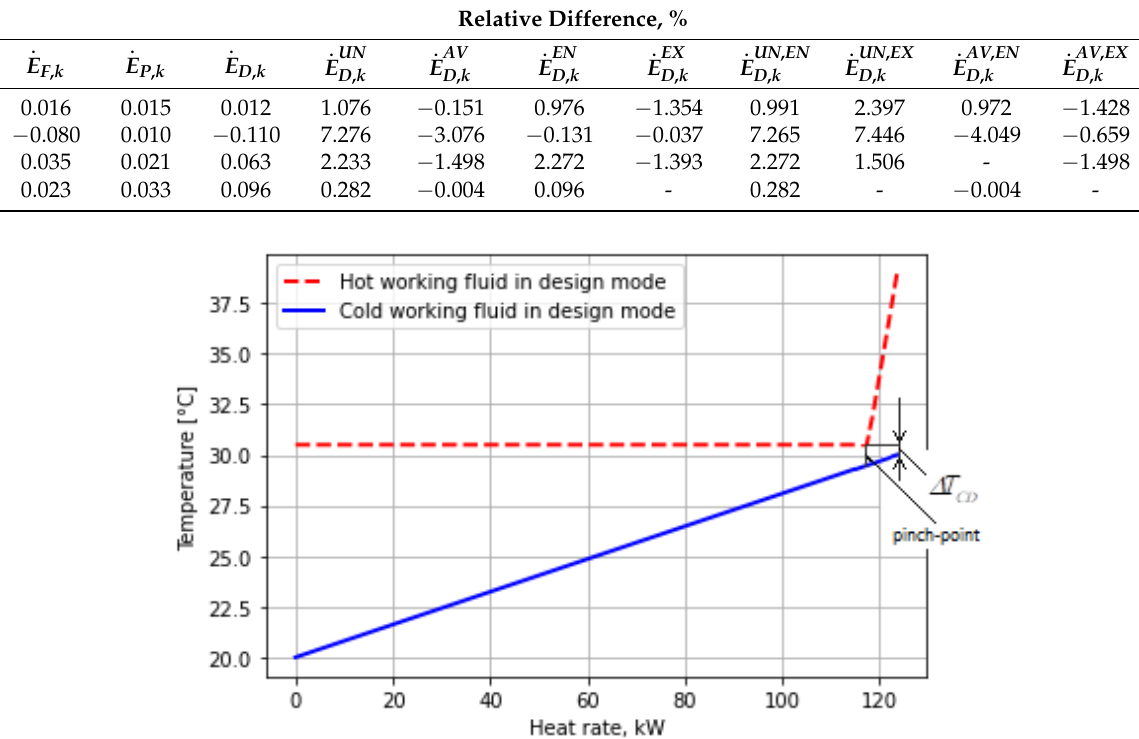
Table 8. Comparison of the results obtained from the conventional advanced exergy analysis and those obtained on the basis of the approach proposed in this work.